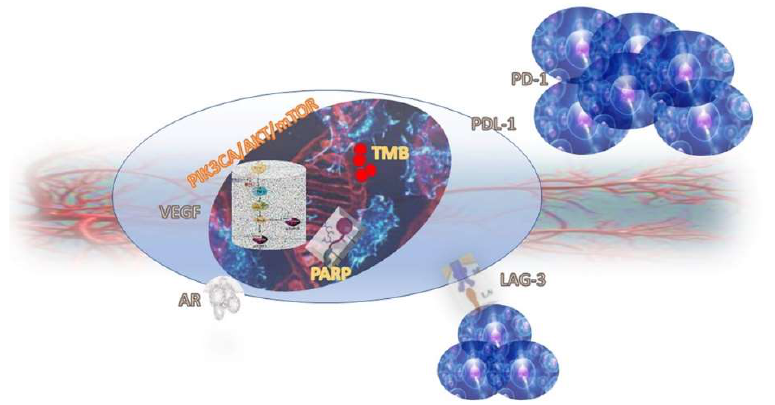
Figure 1. TNBC cell and its